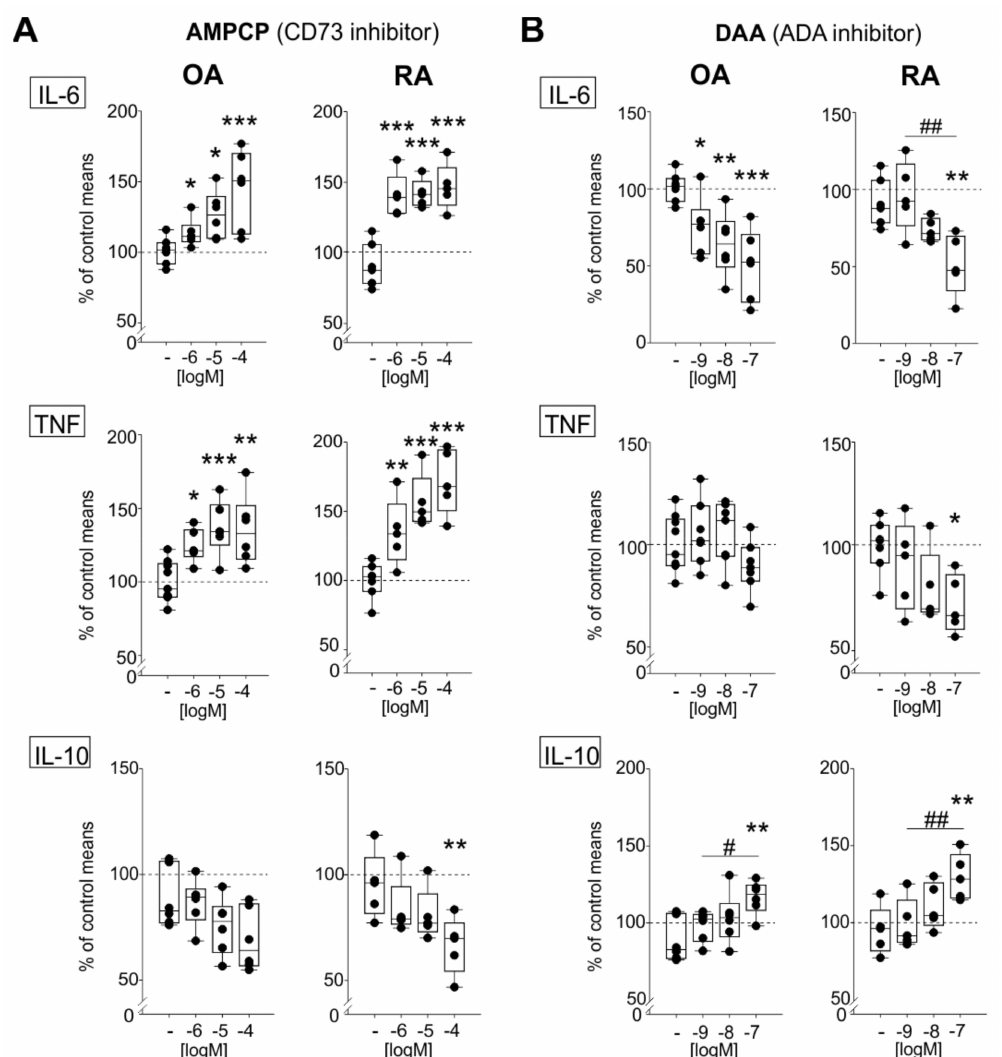
Figure 4. Effects of CD73 and ADA inhibition. ( A ) IL-6, TNF, and IL-10 release in OA and RA mixed synoviocyte cultures after CD37 inhibition using AMPCP (10 − 6 M to 10 − 4 M). ( B) IL-6, TNF, and IL-10 release in OA and RA mixed synoviocyte cultures after ADA inhibition using DAA (10 − 9 M to 10 − 7 M). Data are represented as box plots (as explained in the legend of Figure 1). Values are expressed as percent of untreated control (untreated control is represented as “-“; the mean of untreated controls is represented as dashed line = 100%). Significant p -values are presented as * p ≤ 0.05 ** p ≤ 0.01 *** p ≤ 0.001 when compared to untreated controls or as # p ≤ 0.05 ## p ≤ 0.01 when two treatment groups were compared. Abbreviations: see legends to Figures 1 and